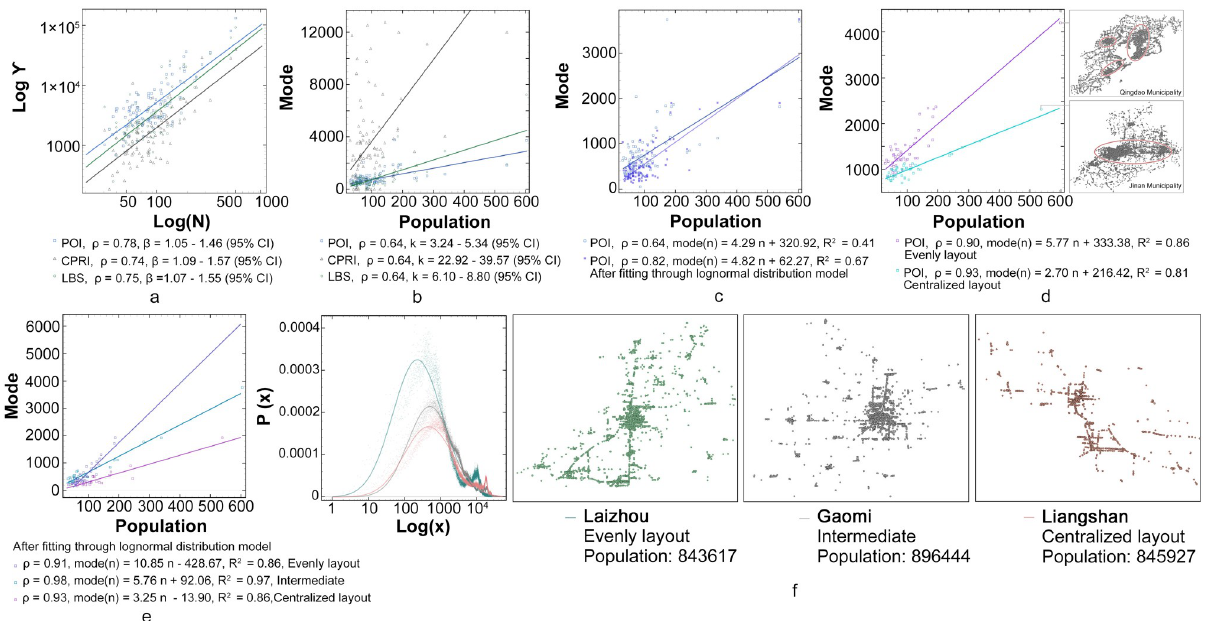
Fig 3. Relationship between internal node layout and the city size. a) Shape of three data types after model fitting; b) Plot of relation between datasets and population under 95% confidence interval; c) Correlation between the mode of POI data and population before and after the log-normal distribution fitting; d) Two classification results of the POI data; e) Three classification results of the log-fitted data; f) Curve of data in log-linear coordinates and spatial patterns of the three cities.